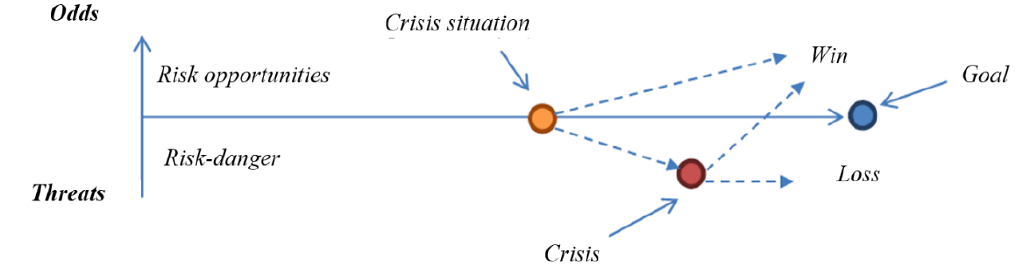
Figure 1. Risks and opportunities as criteria for the effectiveness of the investment project of the